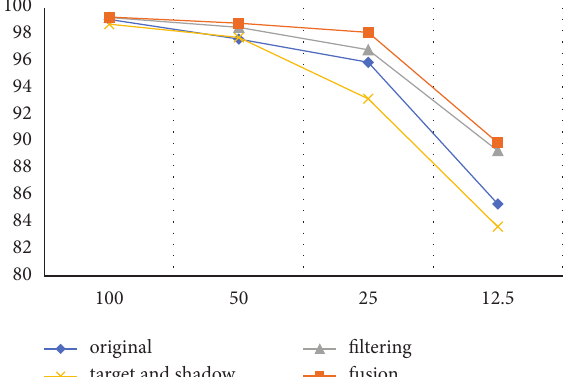
Figure 16: Recognition rate under different